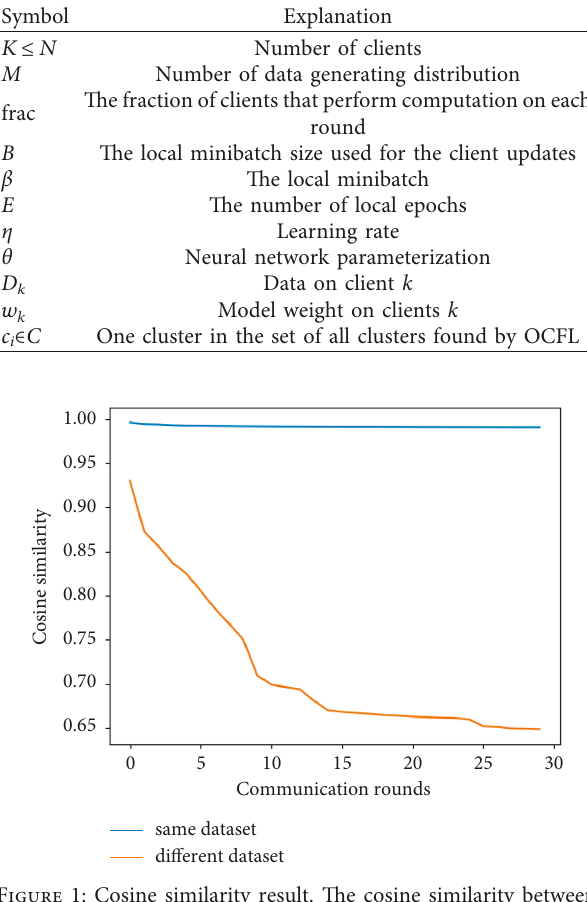
Table 1: Summary of symbols. Symbol